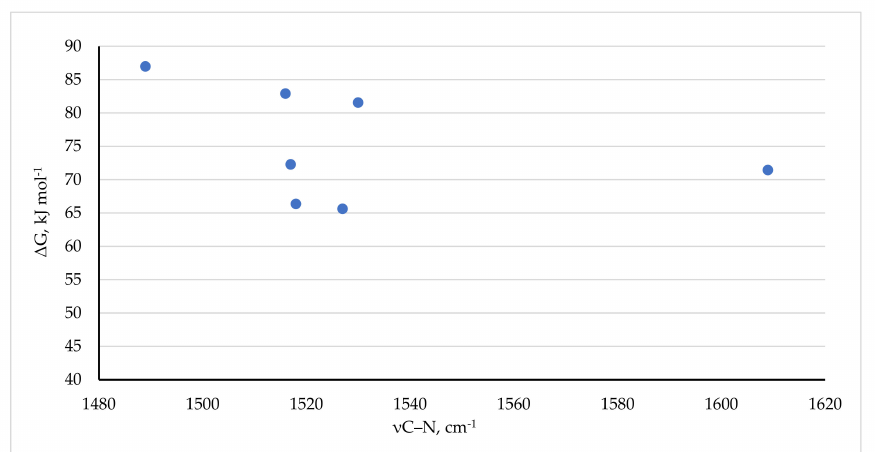
Figure 17. Correlation of ν C–N with the barrier to C–N bond